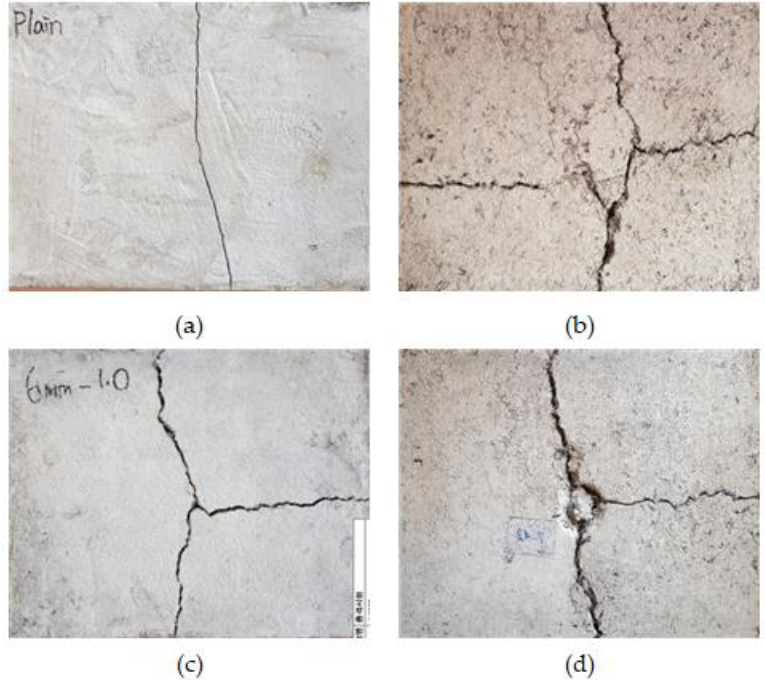
Figure 11. Failure surface of specimens under impact resistance; ( a ) PM, ( b ) MFRCM (SF), ( c ) MFRCM (CF), and ( d ) HyFRCM (SF and CF).